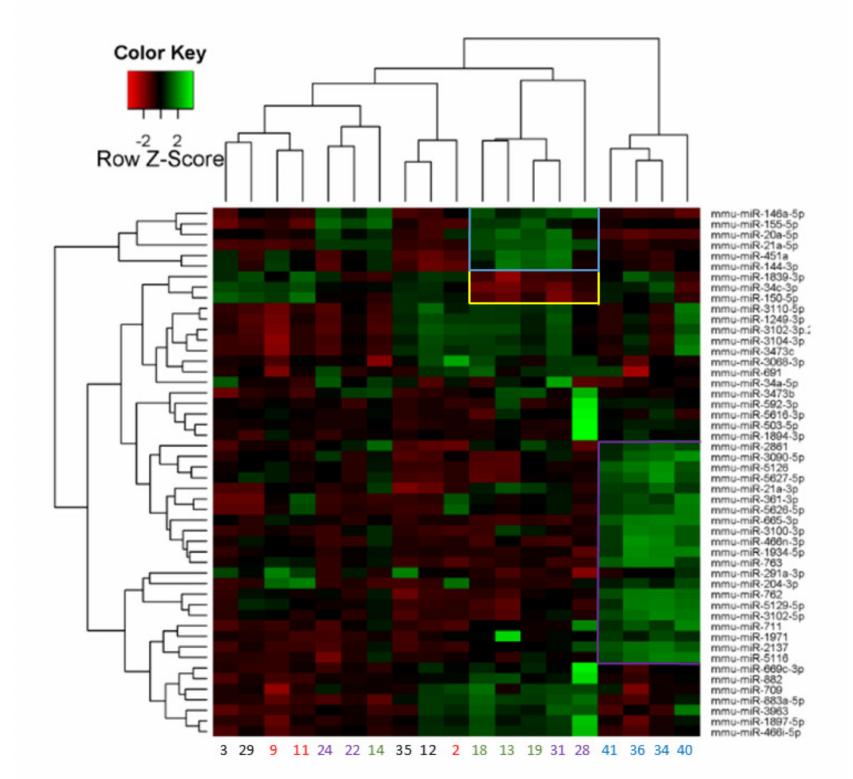
Figure 3. Two-way hierarchical clustering of the top 50 miRNAs with the largest di ff erence between LPS and saline-treated mouse kidneys. Each row represents a miRNA and each column represents a sample. Clustered miRNAs are marked with blue-, yellow-, and purple frames. Samples are saline: #3, 29, 35; 12, EP: 1.5 h: #9, 11, 2; 6 h: #41, 36, 34, 40; LP: 24 h: #14, 18, 13, 19; 48 h: #24, 22, 31, 28 (based on the heat-map provided by